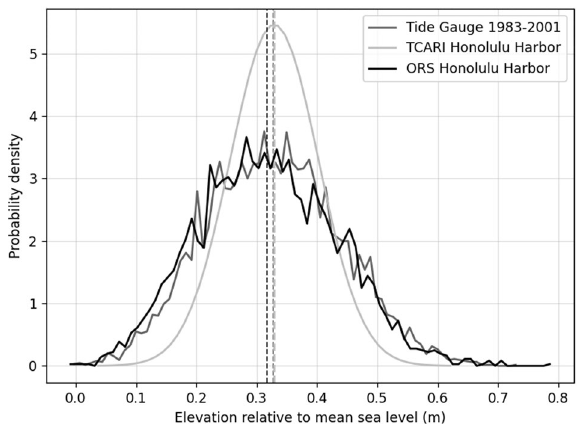
Figure 2. PDFs of daily higher high-water variability as obtained from the Honolulu tide gauge, the ORS, and a normal distribution of the mean of daily higher high water from the TCARI tidal surface. Vertical lines correspond to the mean of the respective